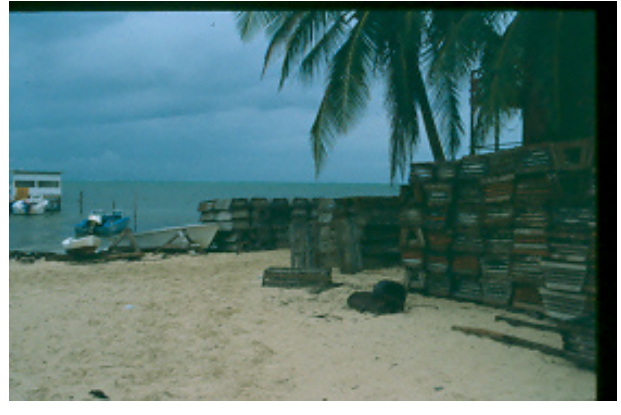
Fig. 4. A fisher's lobster traps stacked on the beach on Caye